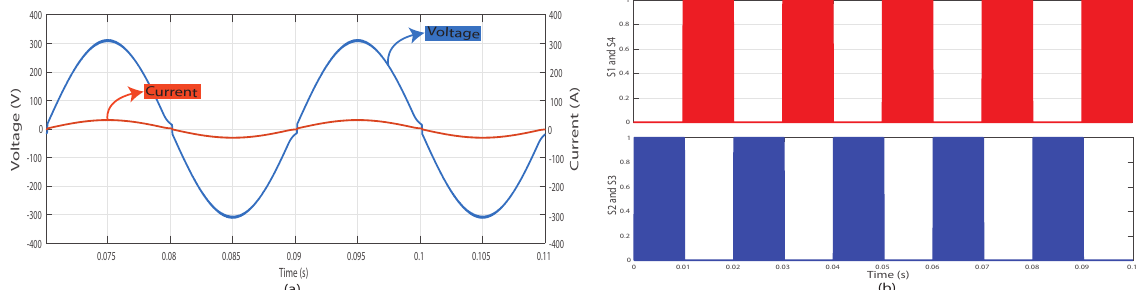
Figure 4. Waveforms of the simulation results. ( a ) Output voltage and current of unipolar power inverter. ( b ) Switching signals of inverter with 180 degree phase